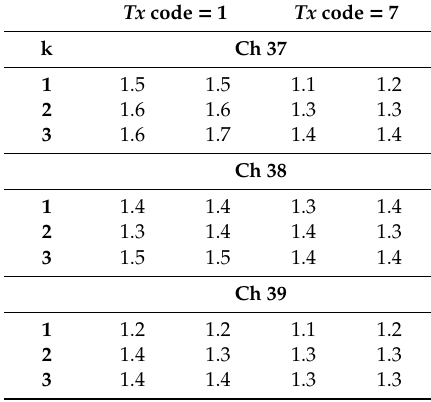
Table 13. Accuracies (in m) for Tests #4. For each Tx code, the first and second data columns refer to the iBeacon and Eddystone protocol respectively. The three advertising channels are referred to as Ch 37, etc., and the number of neighbors in the WKNN algorithm, as k